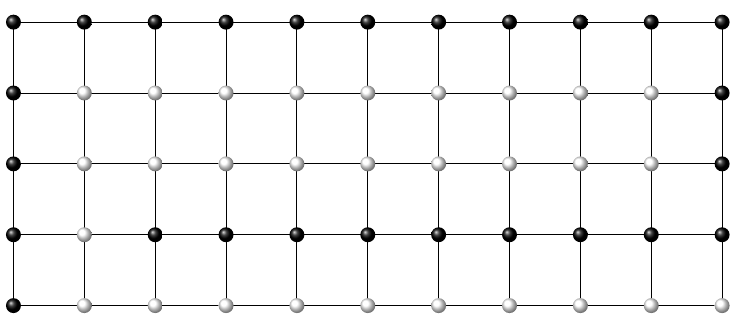
Figure 6. A minimum doubly connected dominating set of G [ 11,5 ] formed by the set of all black